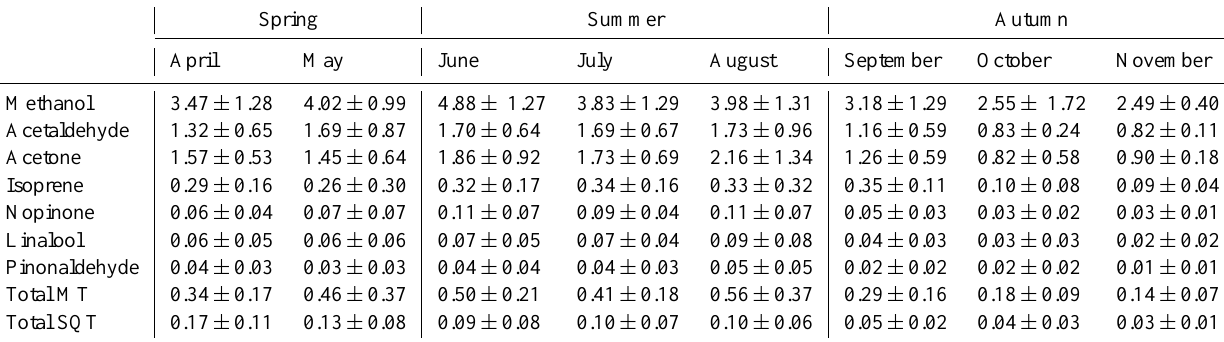
Table 3. Mean ambient mixing ratios (in ppbv) along with their standard deviations for each month.